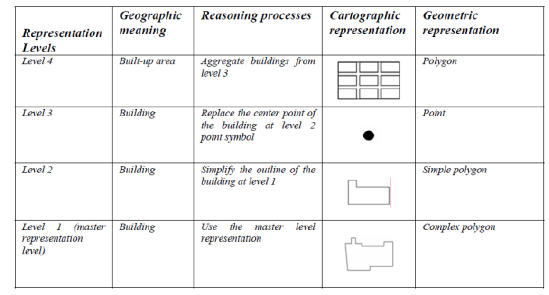
Figure 1. MRDB levels (Kilpelainen 1997).